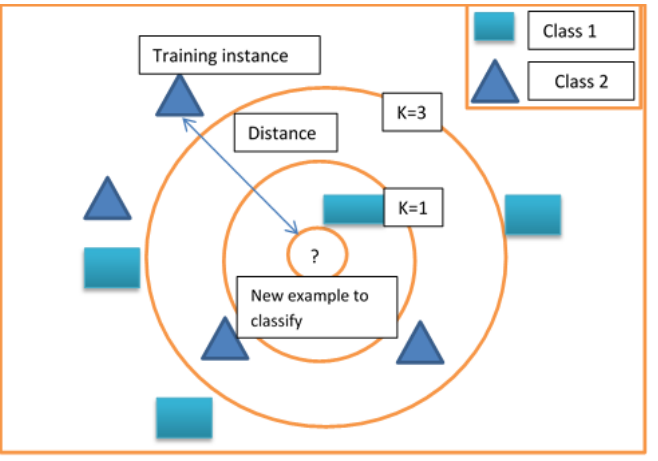
Figure 3. Example of K-nearest neighbors (